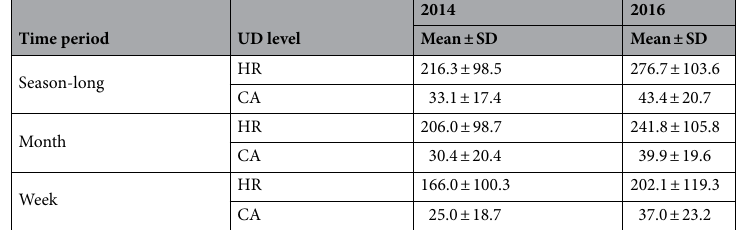
Table 1. Mean and standard deviation (SD) of wild pig ( Sus scrofa ) home range and core area sizes (hectare) across time periods (Season-long [ n